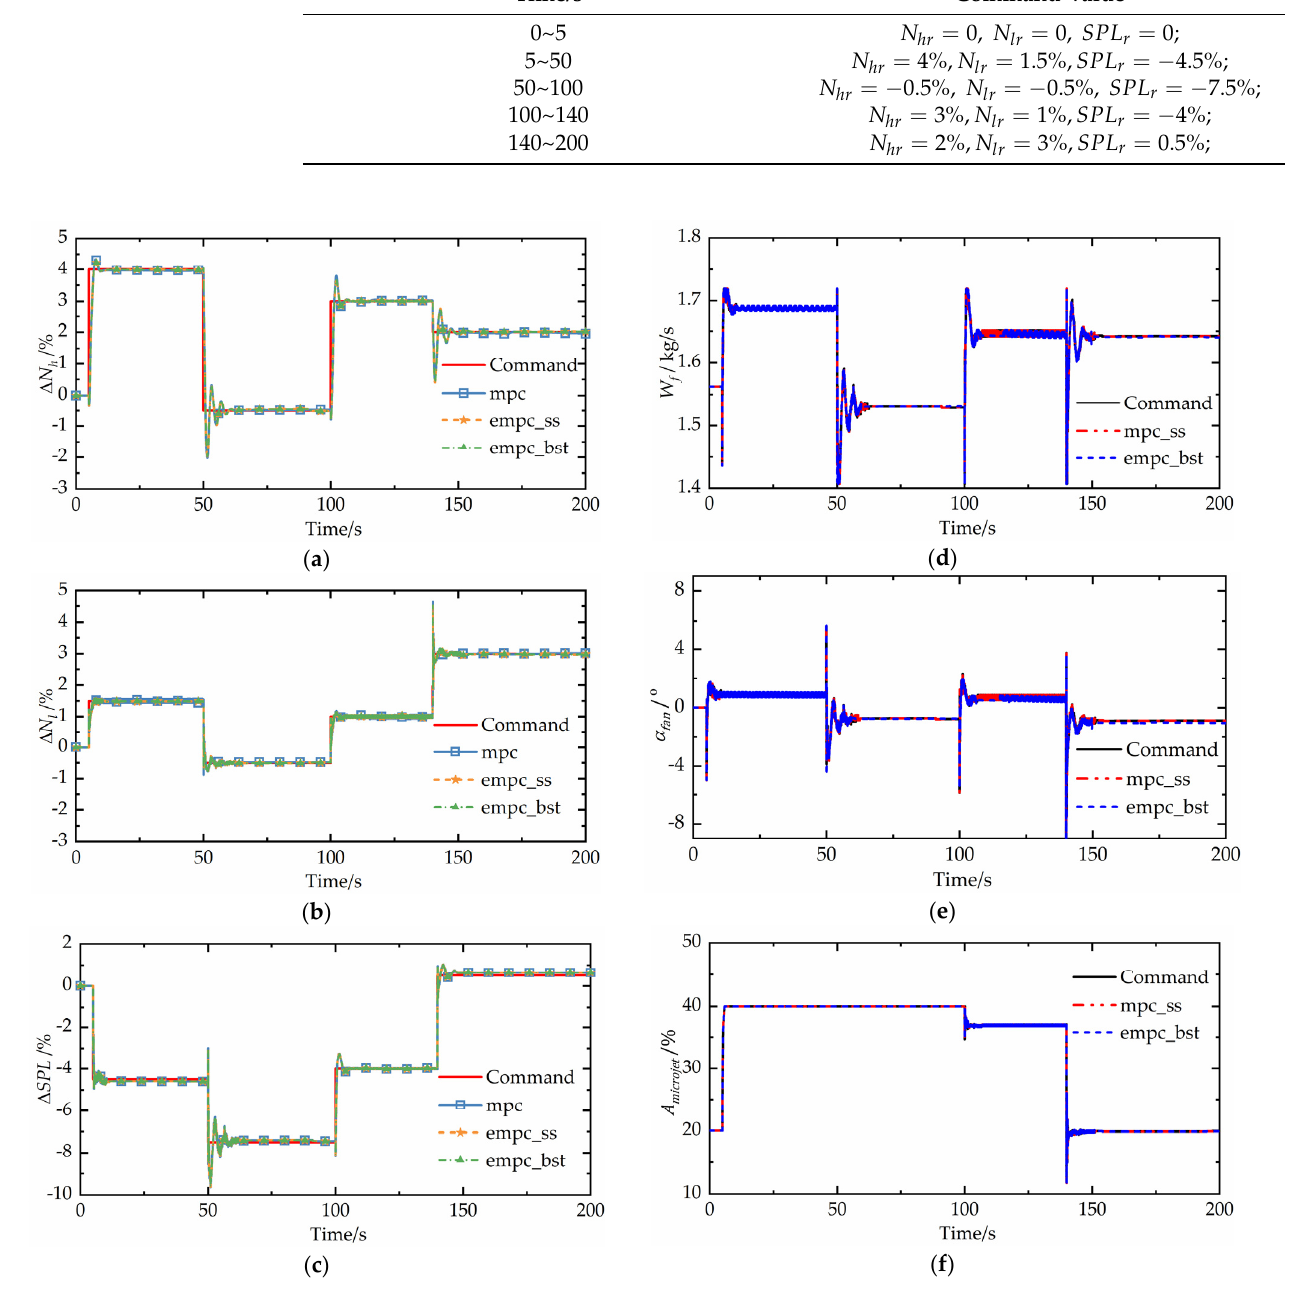
Figure 8. Continuous step responses between different controllers. ( a ) Variation of speed of high pressure rotor. ( b ) Variation of speed of low pressure rotor. ( c ) Variation of total sound pressure level of jet noise. ( d ) Variation of fuel flow. ( e ) Variation of inlet guide blade angle of fan. ( f ) Variation of area of micronozzle throat.